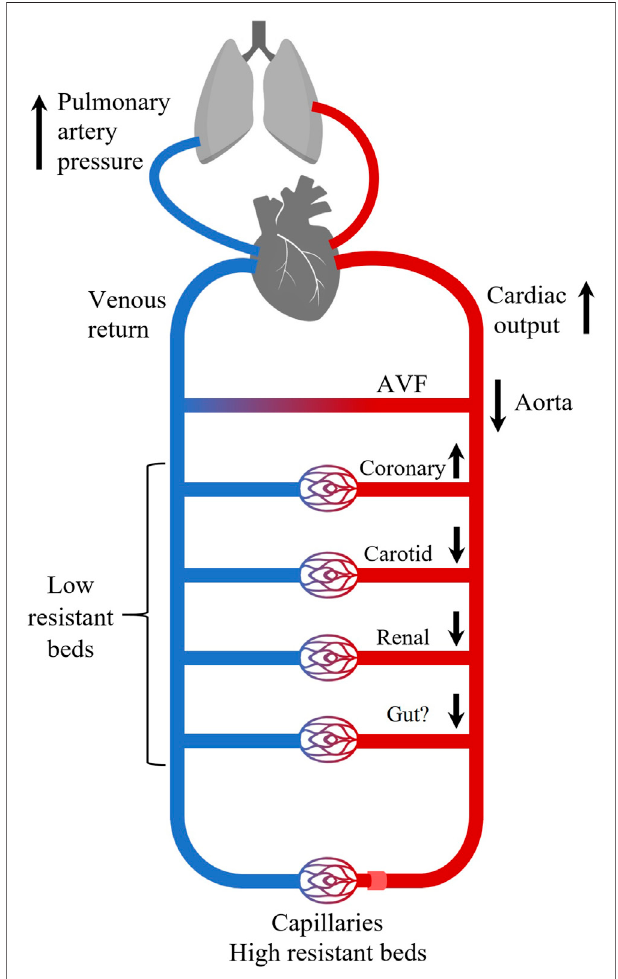
FIGURE3| Theacuteeffectsofhigh- fl owAVFonsystemichemodynamics. Opening of a high- fl ow arteriovenous fi stula increases cardiac output (CO) and coronary blood fl ow at cost of perfusion of other vascular beds (brain, kidneys, peripheral tissues). We did not measure gut perfusion, but it could be in fl uencedtoo.IncreaseinCOleadstoincreaseinpulmonaryarterypressure.High resistant beds refer to arteries supplying extremities and other striated muscles. Arrows indicate increase/decrease of blood fl